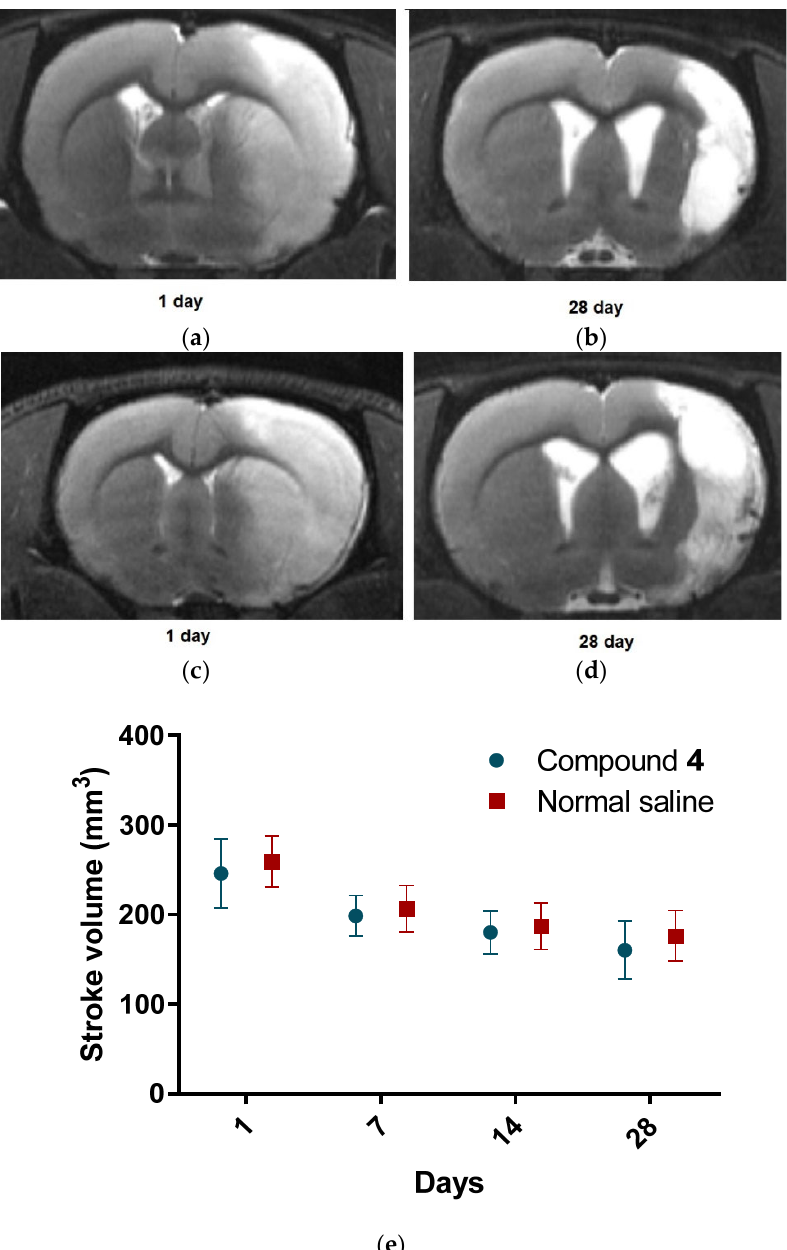
Figure 5. MRI images. T2 ‐ weighted MRI images of the rat brain on postoperative days 1 and 28. The hyperintense zones correspond to ischemic lesions; ( a , b )—Compound 4 , ( c , d )—normal saline. Stroke volume in mm 3 ( e ). Compound 4 —green. Normal saline—red. Data are presented as mean and SD. ANOVA was used for significance calculation.